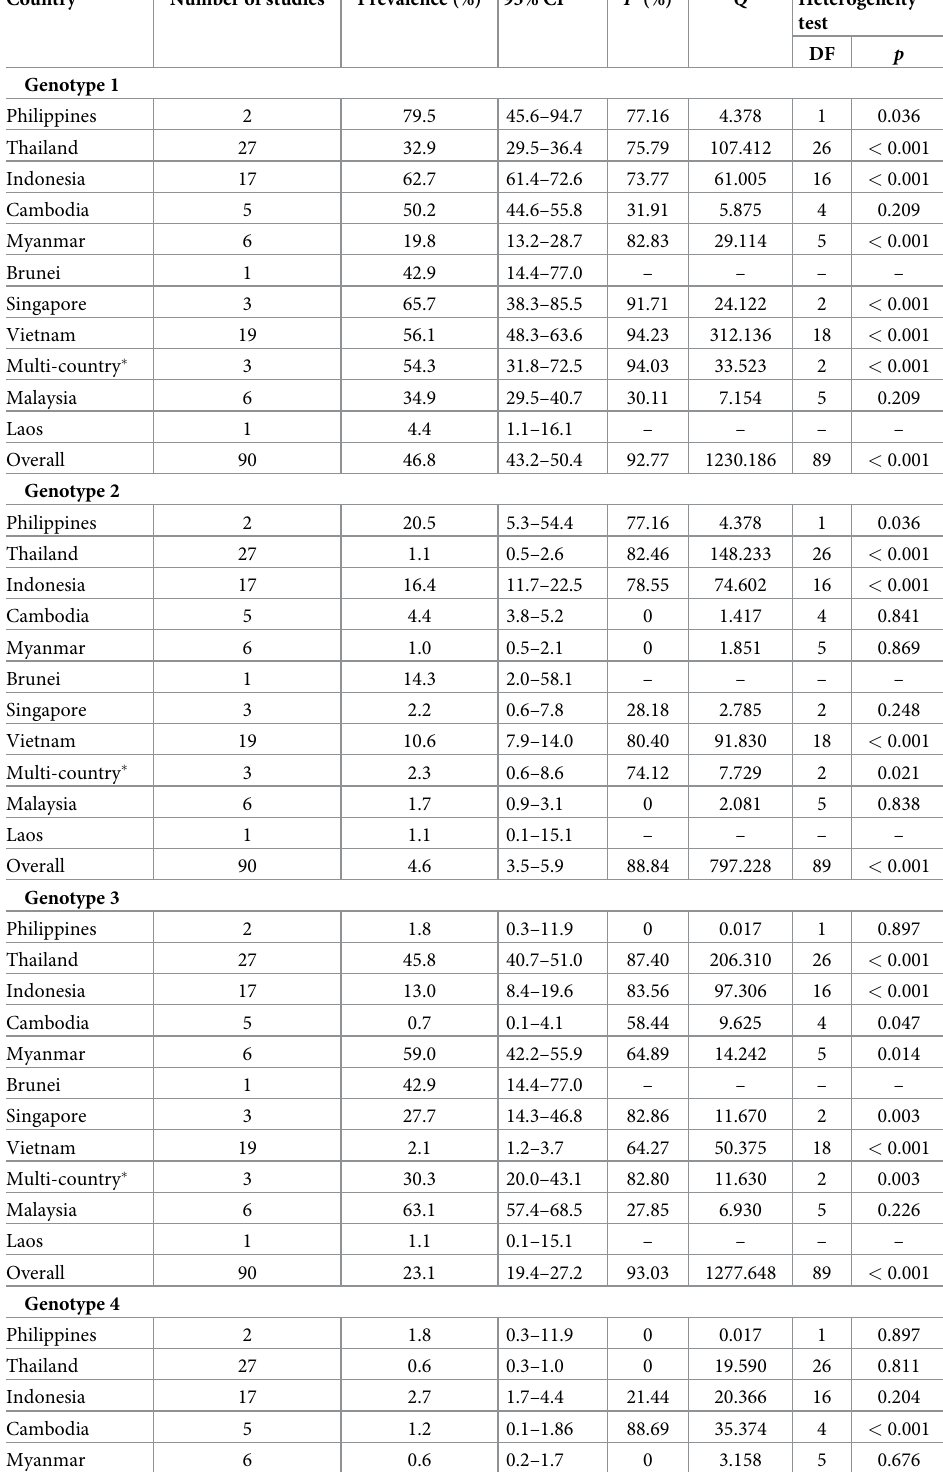
Table 2. Subgroup analysis for comparison of genotype distribution across Southeast Asian